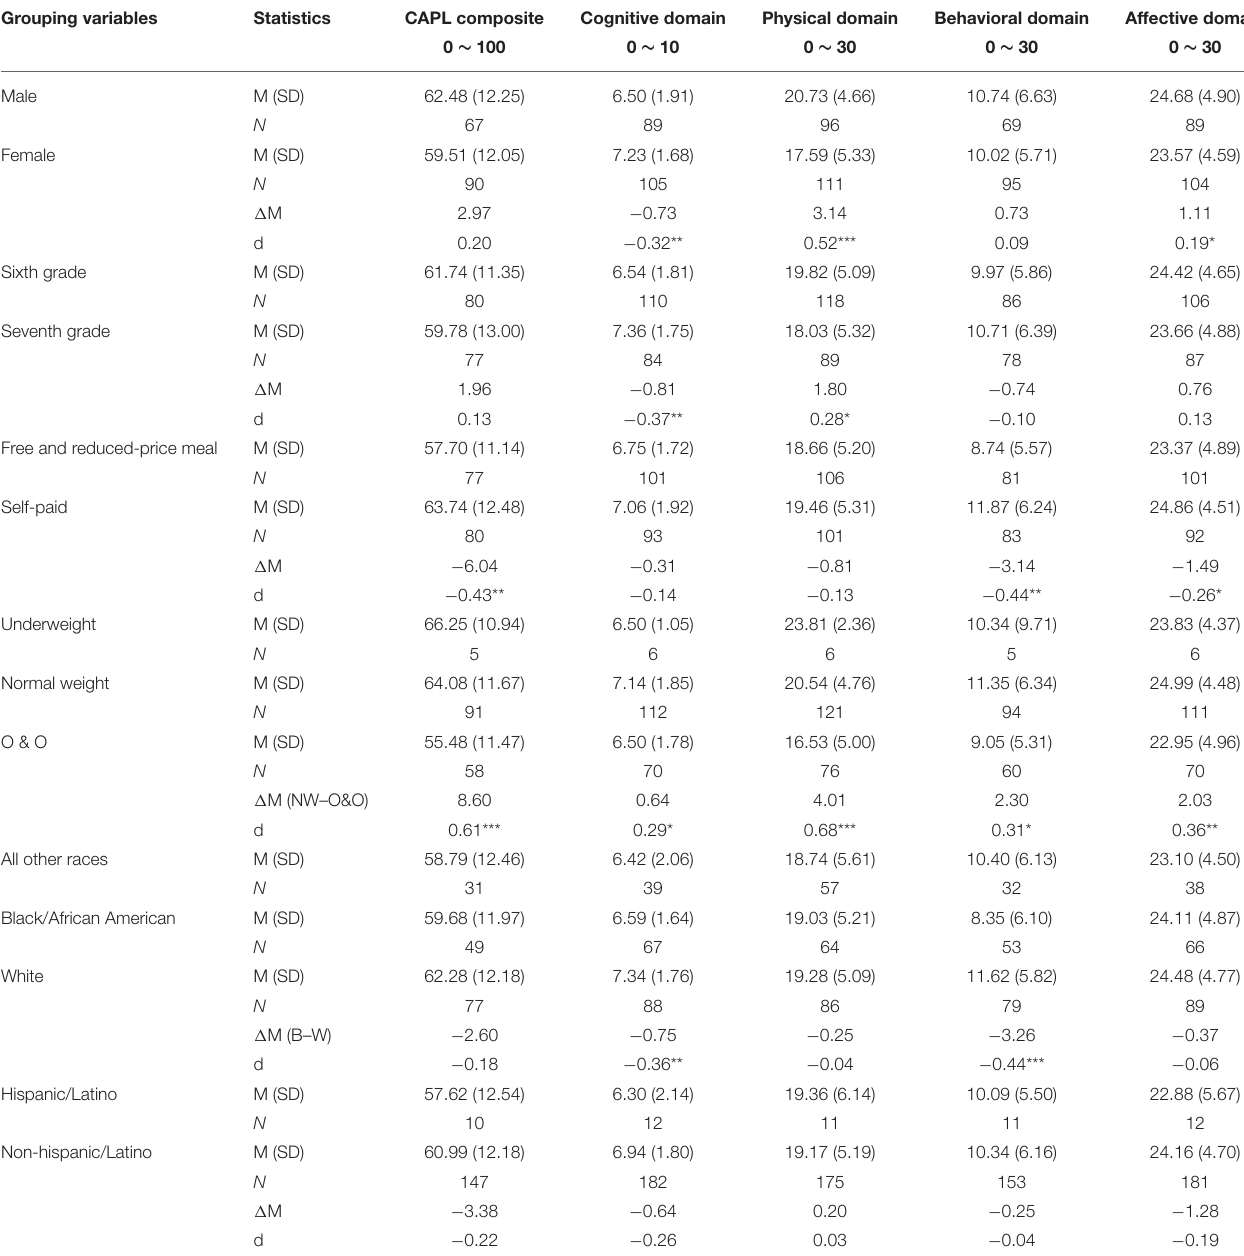
TABLE 4 | PL statistics by gender, grade, SES, BMI, race, and ethnicity. Grouping